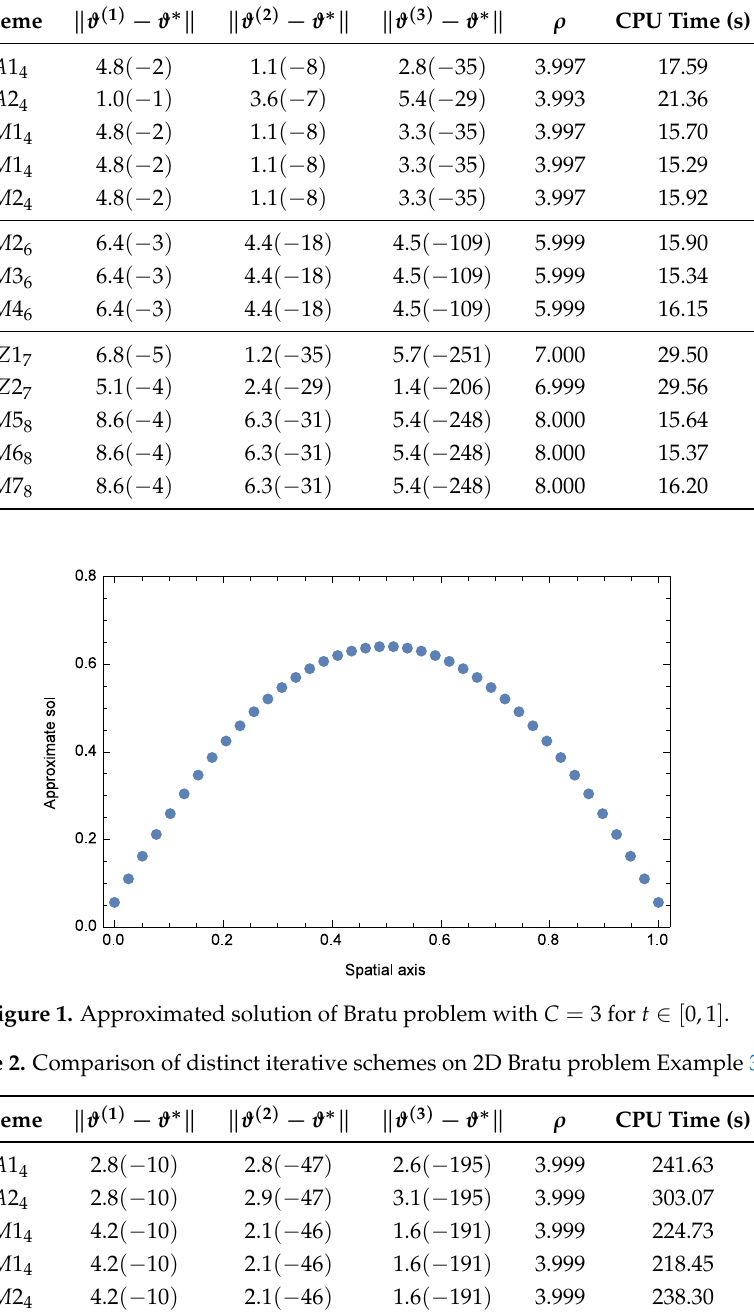
Table 1. Comparison of distinct iterative schemes on Example 2.